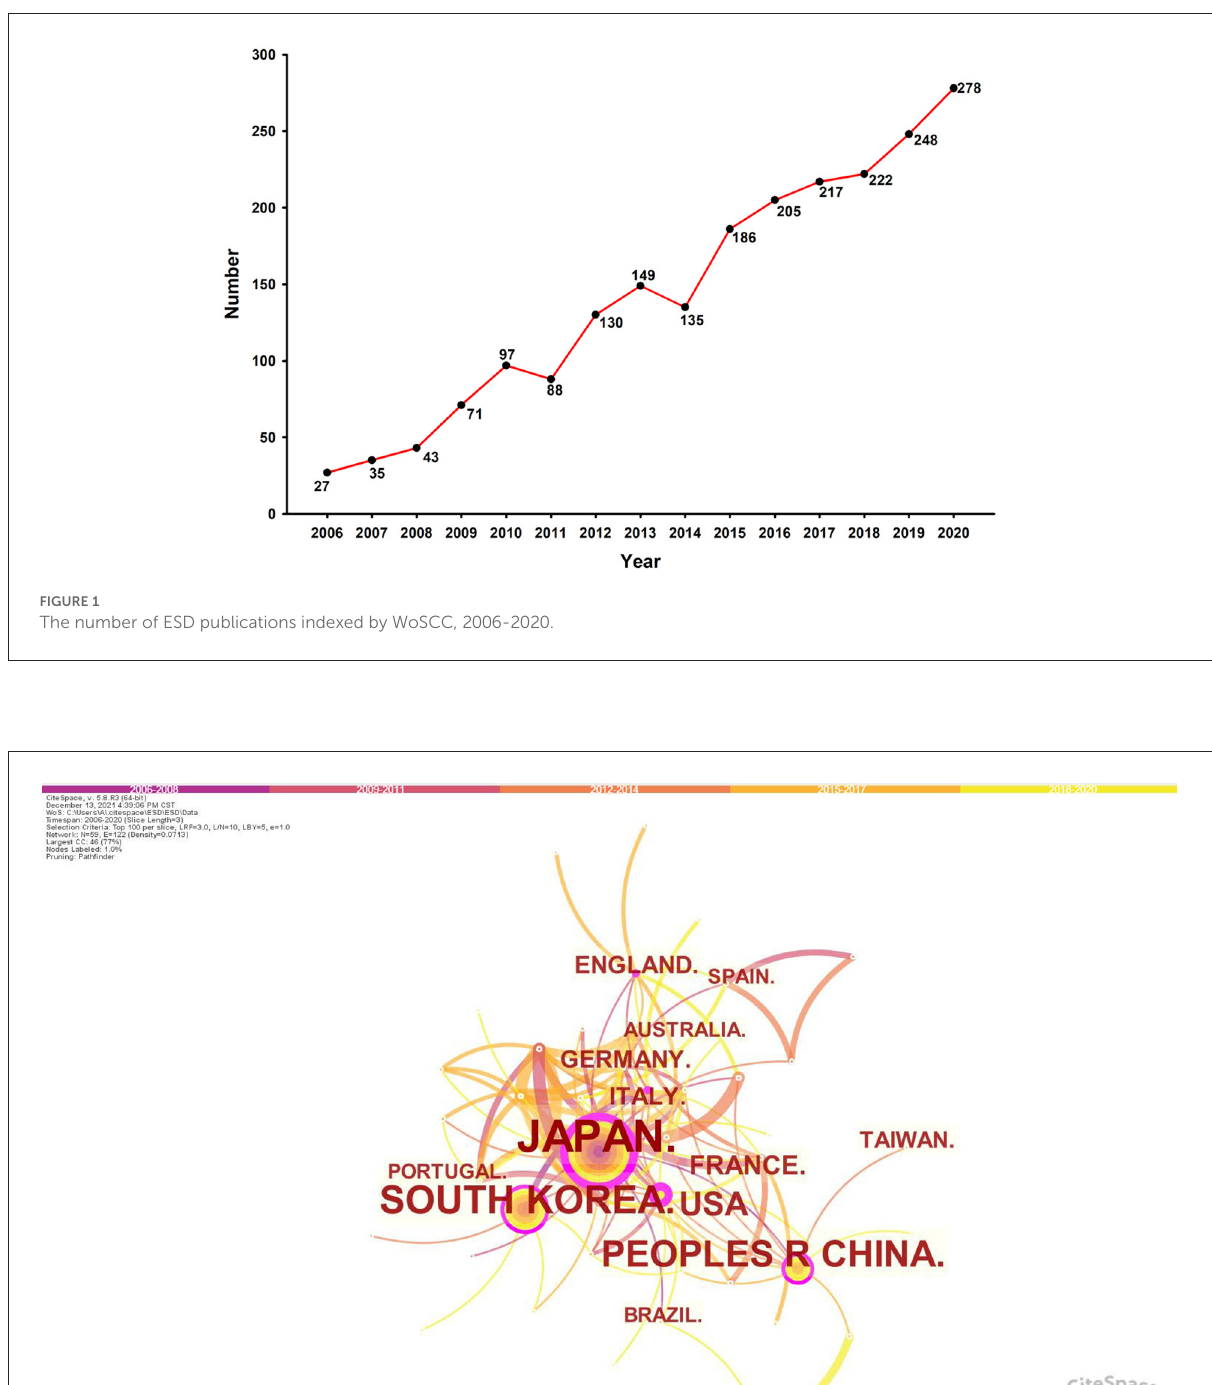
FrontiersinPublicHealth